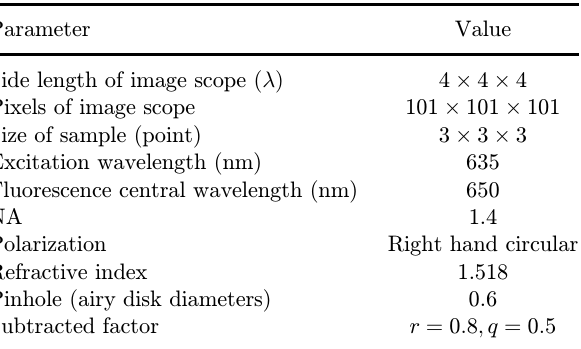
Table 1. System parameters for